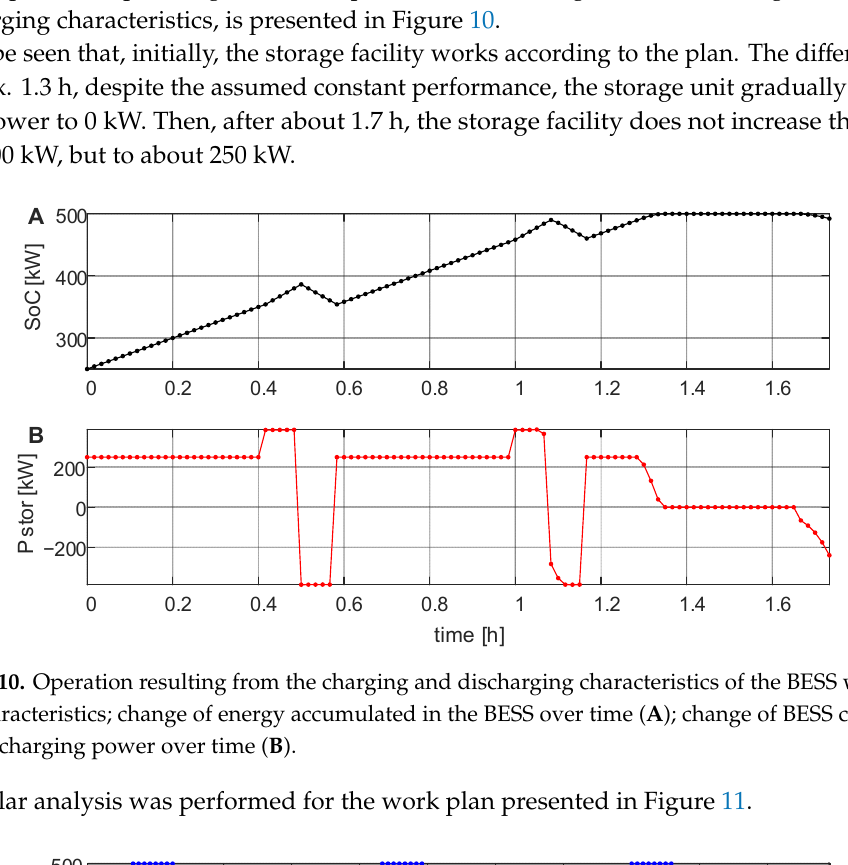
Figure 12. Operation resulting from the charging and discharging characteristics of the BESS with the real characteristics ; change of energy accumulated in the BESS over time ( A ); change of BESS charging and discharging power over time ( B ). As before, the storage unit initially works according to the operation plan, the difference occurs after approx. 0.6 h. The storage starts to reduce the discharge power faster than the plan would have